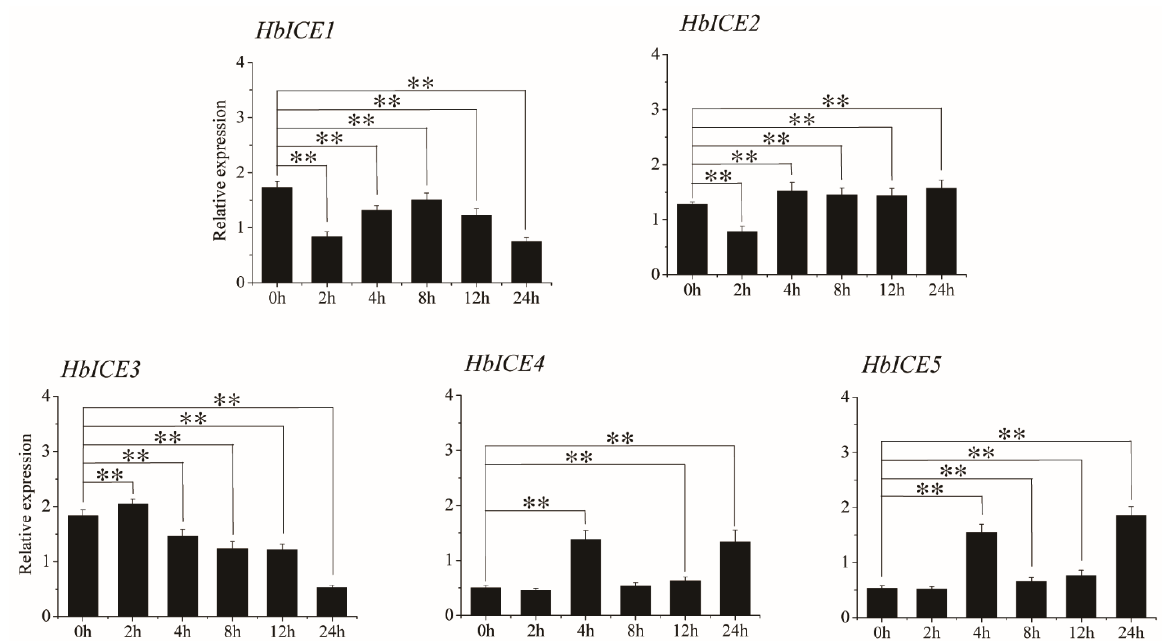
Figure 8. Expression profiles of five HbICE genes in rubber tree clone 93-114 under drought stress. The asterisks (**) and (*) respectively represented very significant difference ( p < 0.01) and signifi- cant difference ( p < 0.05).